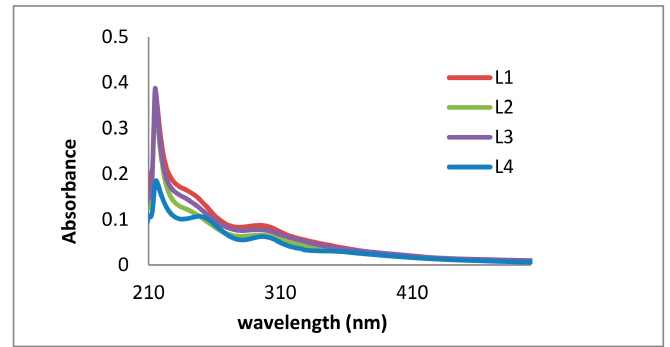
Figure 4. Ultraviolet-visible (UV/Vis) analysis of kraft lignin purification fractions dissolved in NaOH: L1 (red), L2 (green), L3 (purple), and L4 (blue).